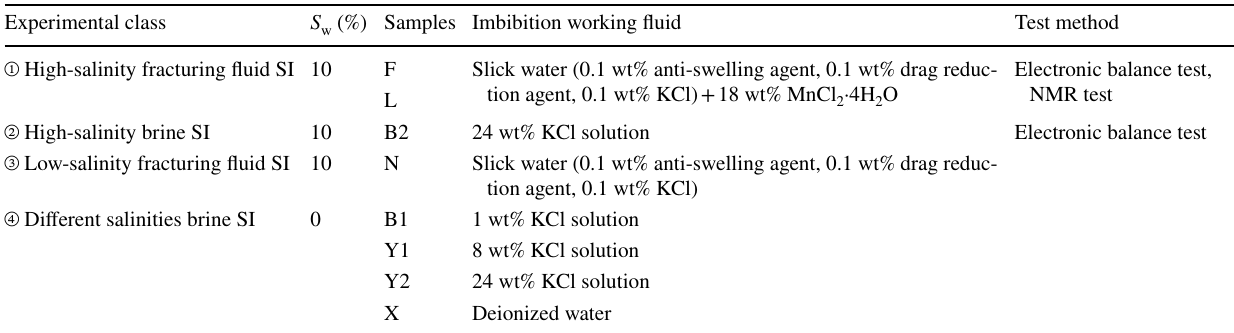
Table 4 Each group of samples corresponding to the imbibition working fluid Experimental class